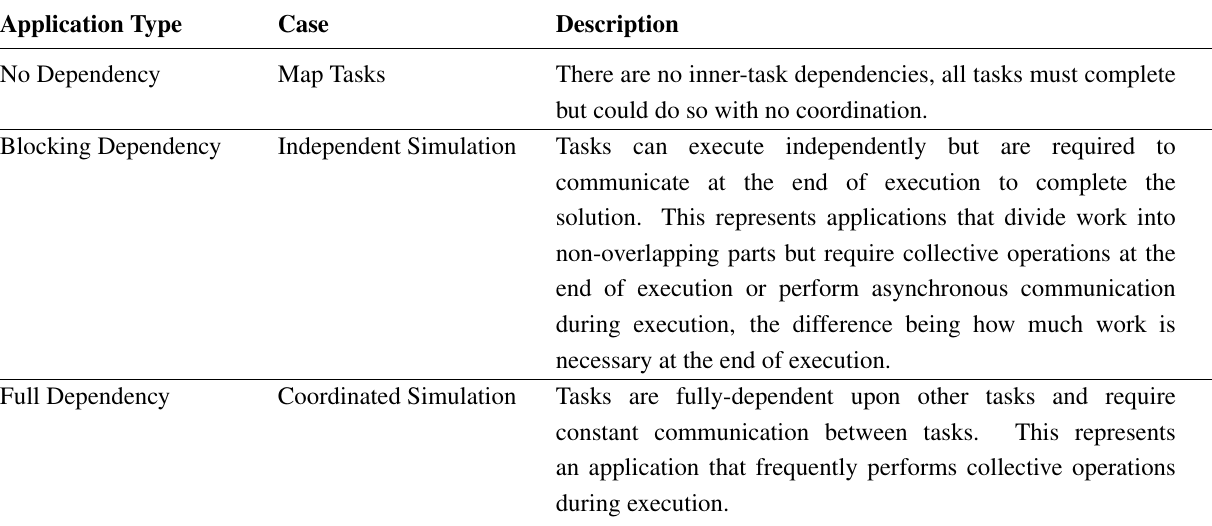
Table 8. Classification of application communication types and their